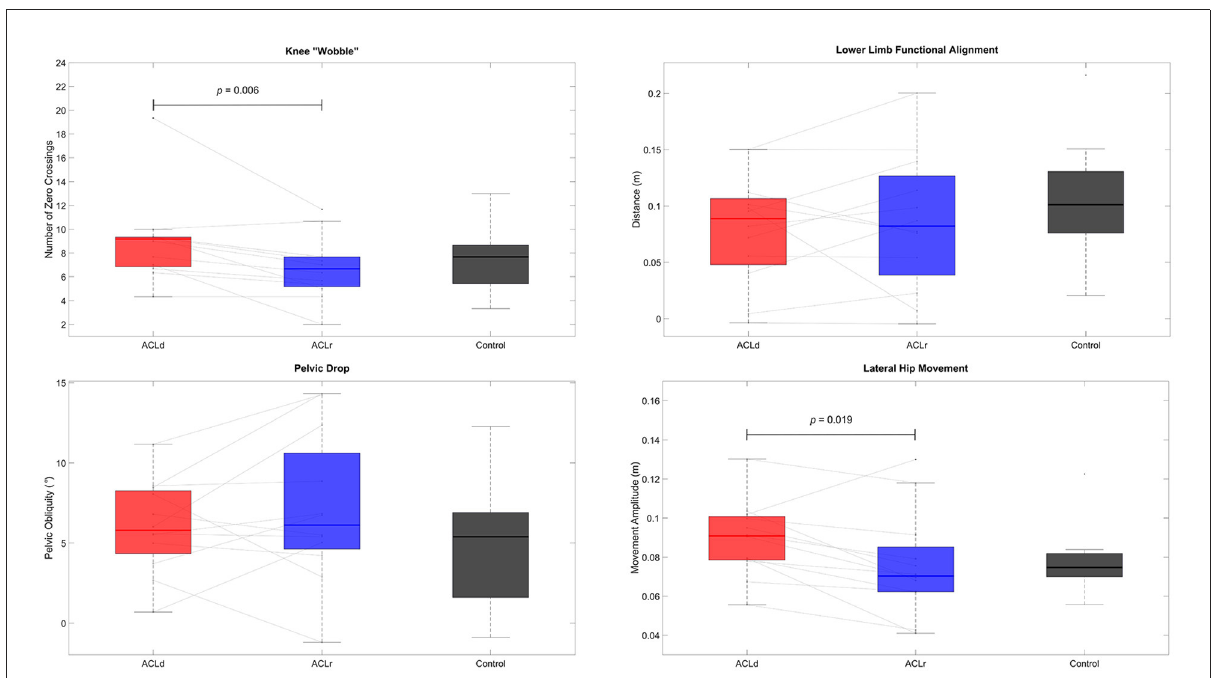
FIGURE3 Objective assessment of movement quality. Knee “wobble”, that is describing the mediolateral movement of the knee during the forward lunge, and lateral hip movement reduced from pre to post ACL reconstruction. None of the measures of movement quality differed between the patients with an ACL injury and healthy